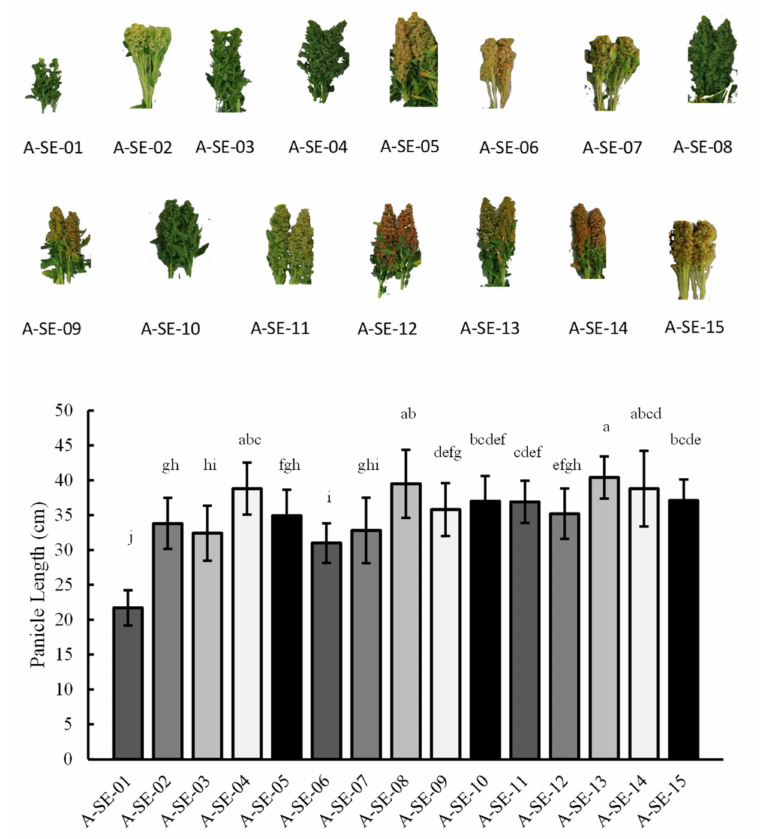
Figure 2. Panicle lenght. Panicle length (cm) was determined in the 15 cultivars analyzed. Error bars represent the standard deviation. Bars that do not share the same letters show statistically significant differences following the Kruskal–Wallis test at a p -value <